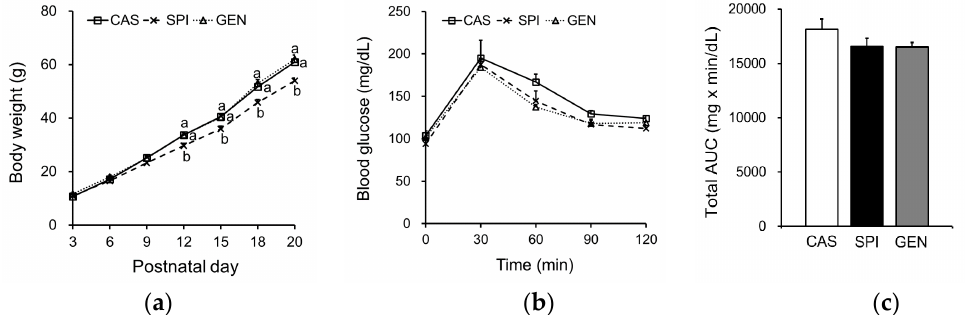
Figure 1. Effects of maternal diet on ( a ) body weight change ( n = 14–17) and ( b , c ) glucose metabolism in male offspring ( n = 4). Blood glucose curve and total area under the curve (AUC) in response to a glucose-loading test. Data are means ± standard error of the mean. Means with different superscripts are significantly different at p < 0.05. CAS, offspring of dams fed a casein diet; SPI, offspring of dams fed a low-isoflavone soy protein isolate diet; GEN, offspring of dams fed a casein plus genistein diet.